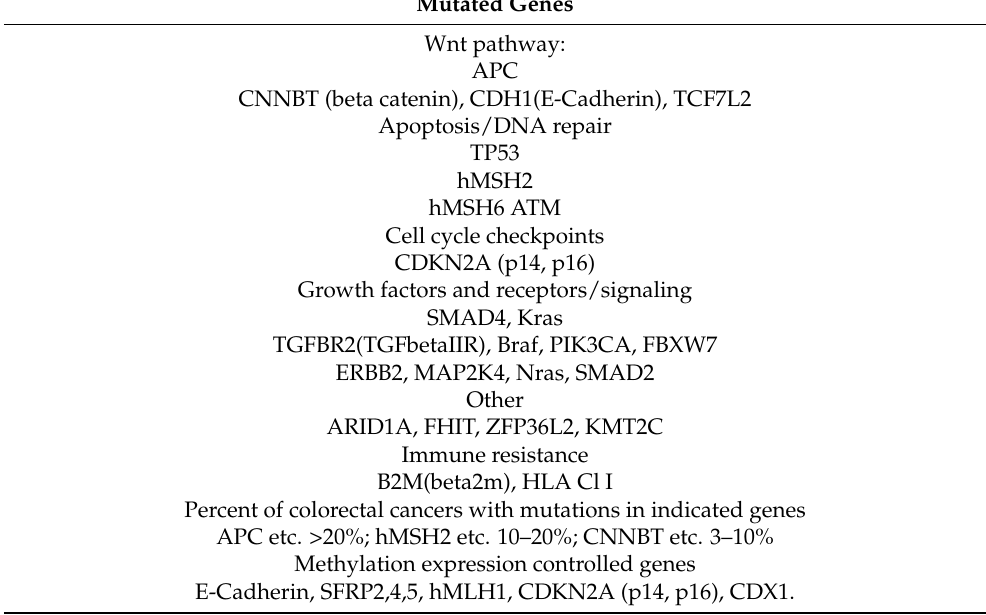
Table 1. Mutated and methylated genes found in Colorectal